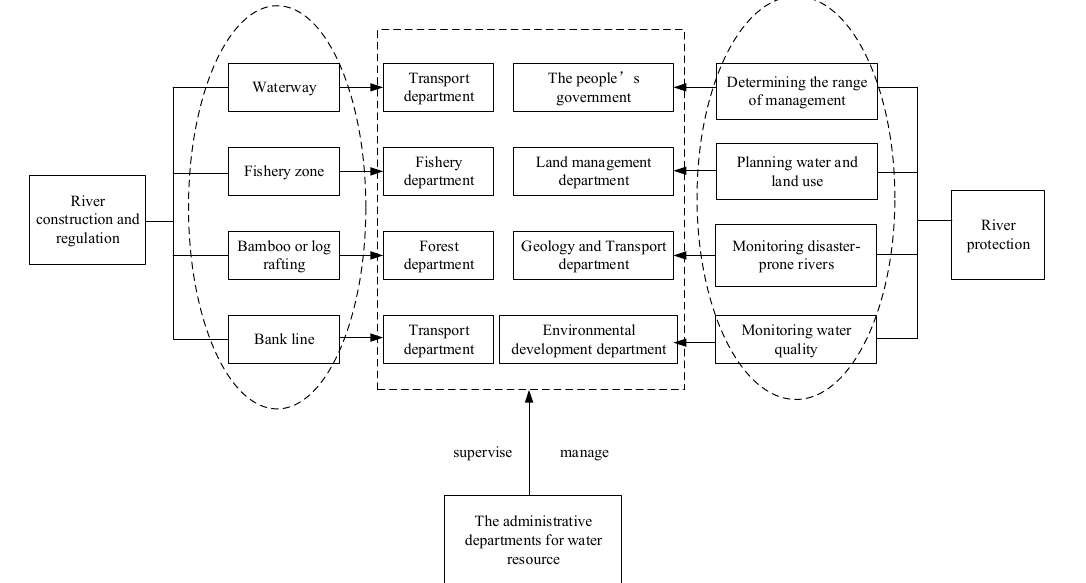
Figure 7. Management system of river management and protection.